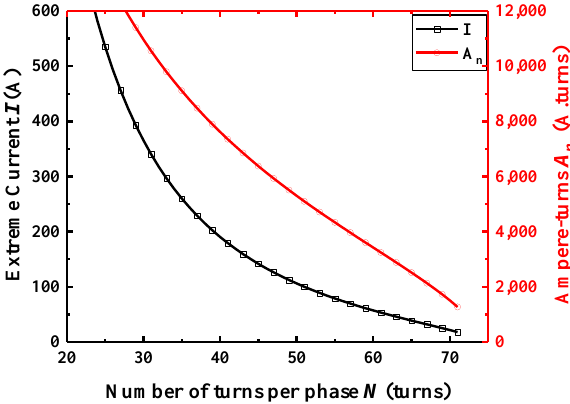
Figure 2. The influences of the number of turns on the extreme current and ampere-turns.